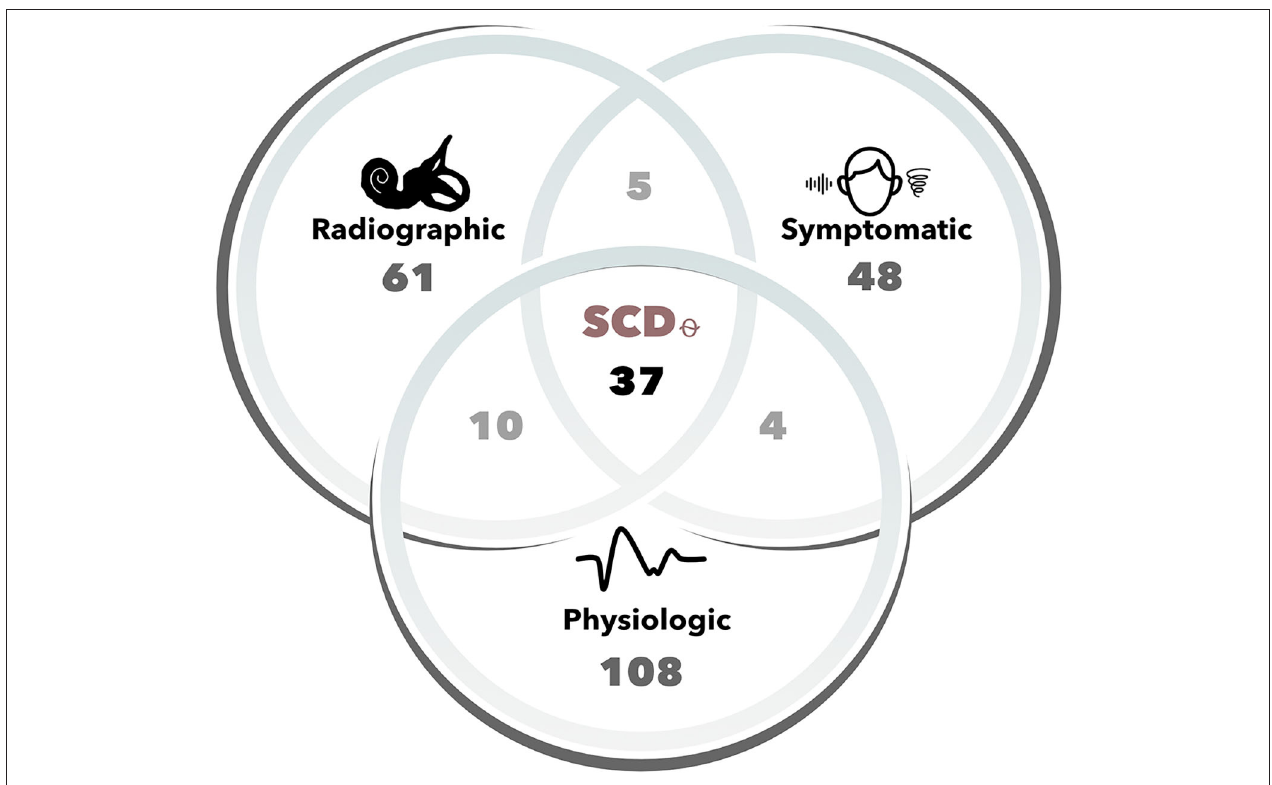
FIGURE 1 | Number of cases for each Ward et al. diagnostic criteria of SCD θ . Cases (i.e., ears) were determined to be radiographically positive based upon two-party review of high-resolution (sub-millimeter) temporal bone computed tomography (CT) scans. Symptomatic cases included one of the following patient-reported symptoms: hyperacusis/autophony, pulsatile tinnitus, sound-, or pressure-induced vertigo. Physiologic cases were those that had either 500Hz oVEMP amplitude ≥ 17 uV, 500Hz cVEMP threshold ≤ 75 dB nHL, or negative bone-conduction thresholds. SCD θ refers to our study cohort of clinically significant SCD, as defined by the radiographic, symptomatic, and physiologic diagnostic criteria proposed by Ward et al.